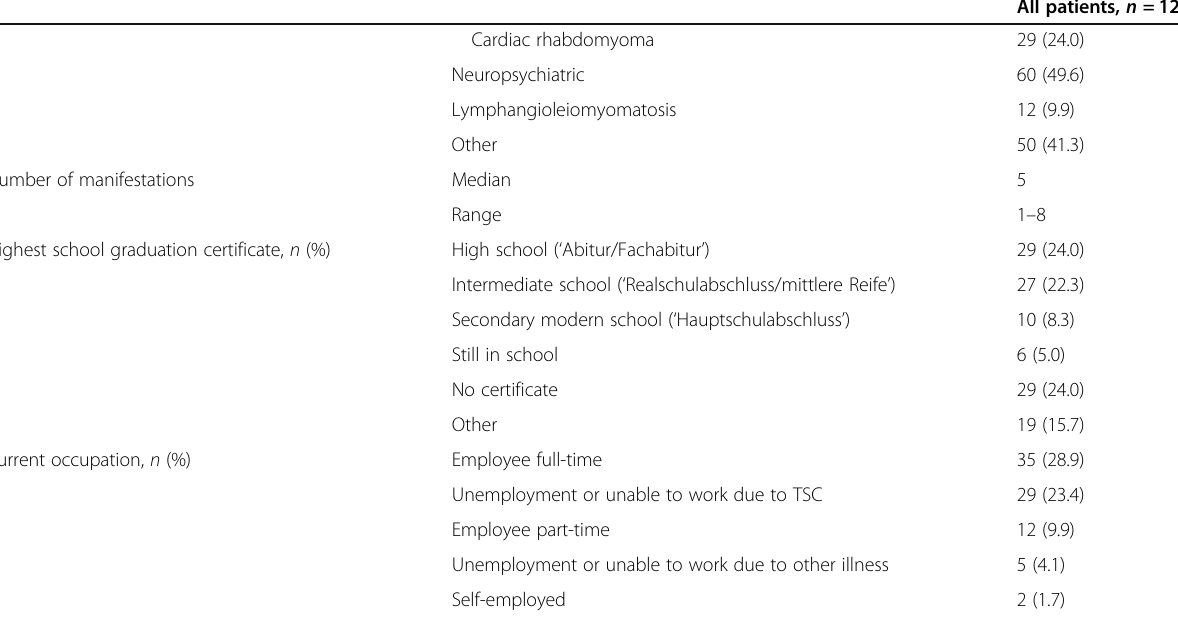
Table 1 Sociodemographic and clinical characteristics of participants ( n = 121)